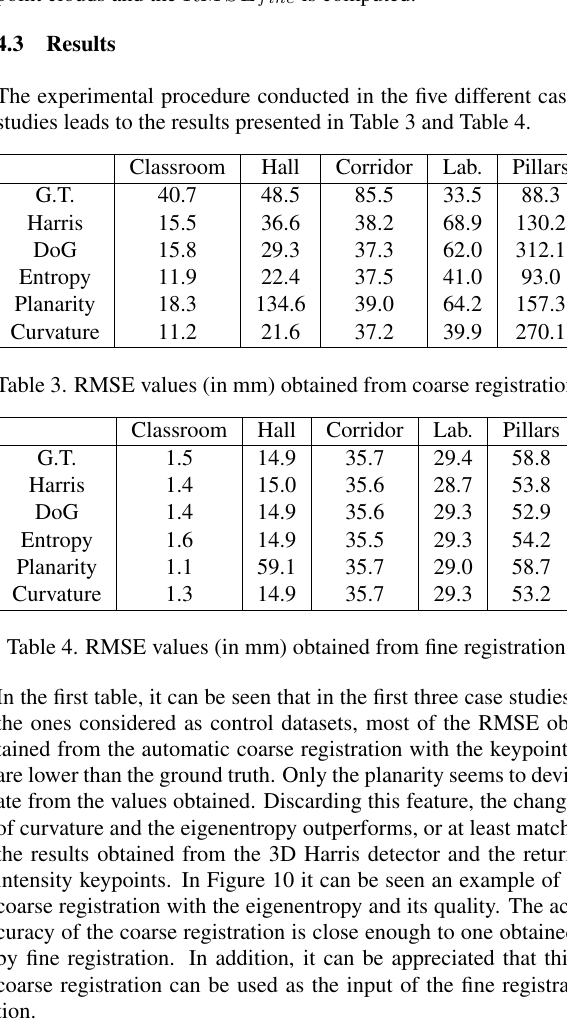
Figure 11. Coarse registration performed from the change in cur- vature on the Pillars